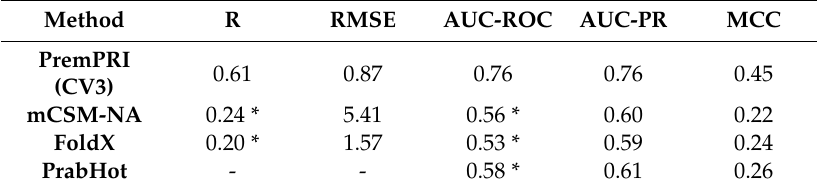
Table 2. Comparison of methods’ performances on the S248